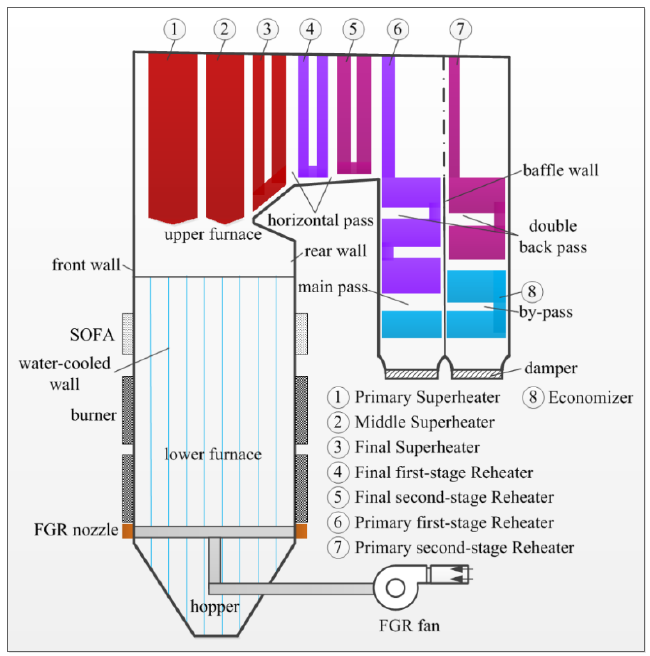
Figure 3. Tangentially-fired double-reheat inverse U-type boiler with double back passes.